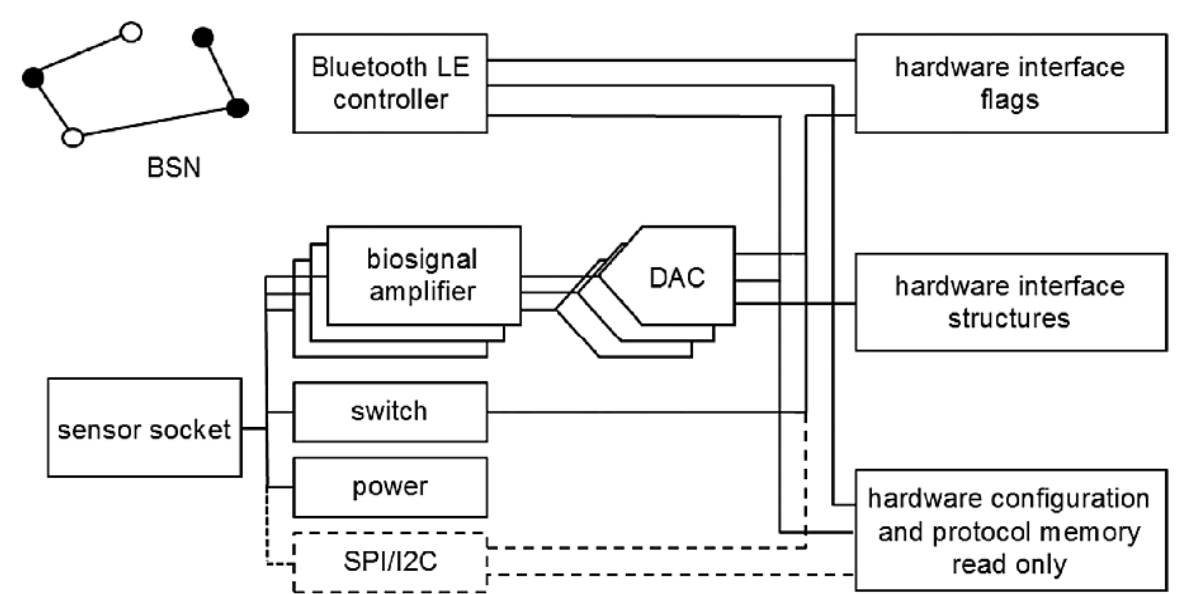
Figure 12. Flow diagram of the data acquisition layer proposed in [129] (Reproduced with permission from [129], Elsevier, 2016).